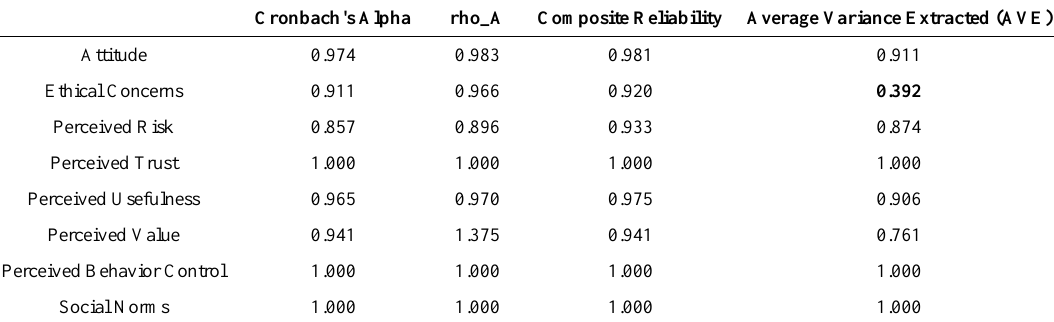
Table 6. Construct Reliability and Validity